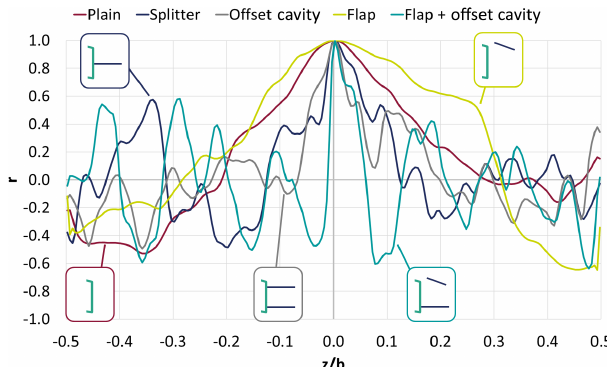
Figure 15. Pearson correlation coefficient of the lift coefficient ( C l ) time series with respect with the midsection (placed at z/b = 0) for the various configurations. High positive values indicate strong pos- itive correlation, and highly negative values suggest a strong nega- tive